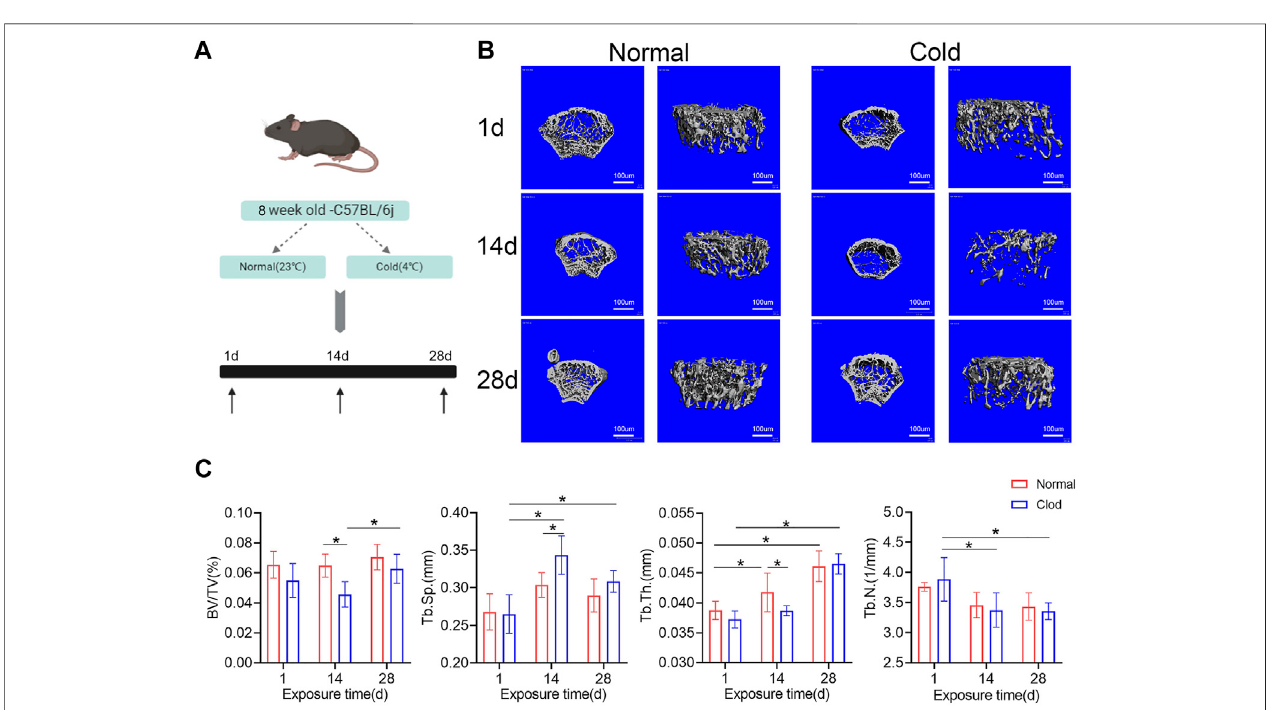
FIGURE 1 | I n fl uence of cold-stress on bone mass in a time-dependent manner. (A) Schematic fl ow of the experimental design. Mice were nursed at different temperatures (4 and 23 ° C) and sacri fi ced after 1, 14 or 28 days. (B) The representative micro-CT 3D reconstruction images of different groups. (C) Trabecular bone microarchitectureoffemursshowingbonevolume/totalvolume(BV/TV),trabecular number(Tb.N), trabecularseparation(Tb.Sp),andtrabecularthickness(Tb.Th).Data are shownasmean ± SD (n (cid:2) 5per group). Signi fi cance ( p value) iscalculatedusing two-way ANOVA, * p < 0.05;Abbreviations:1 day(1d), 14 days (14d), 28 days (28d), Normal: mice in the room temperature, Cold: mice in the 4 °